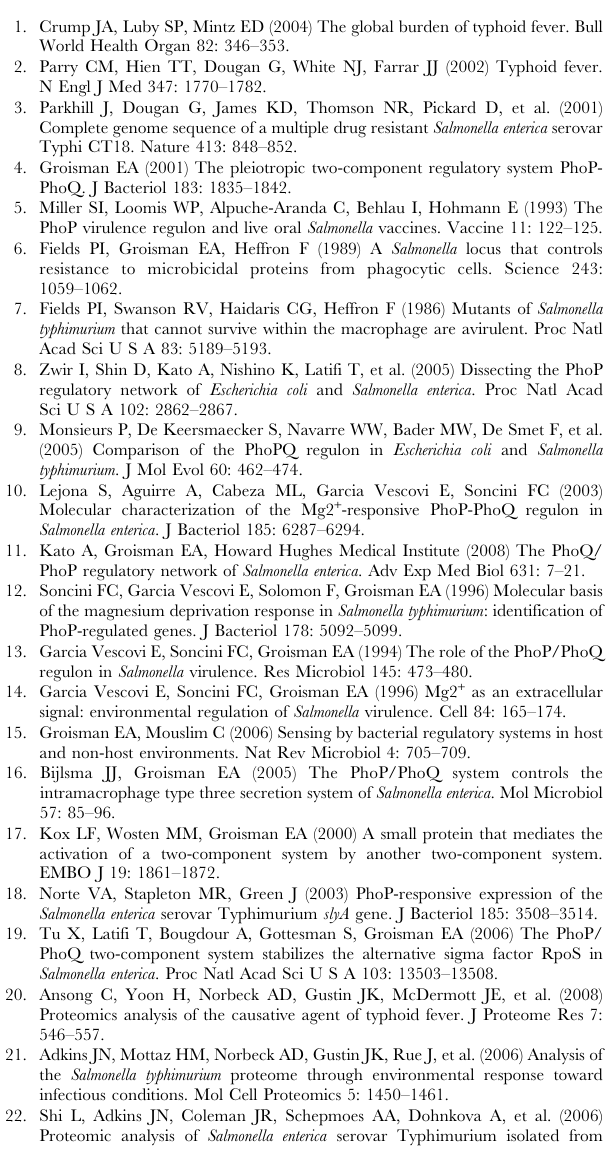
Table S2 PhoP up-regulated proteins identified in both S. Typhi and S. Typhimurium. List of PhoP up-regulated proteins identified in our analysis that are common to both S. Typhi and S. Typhimurium.